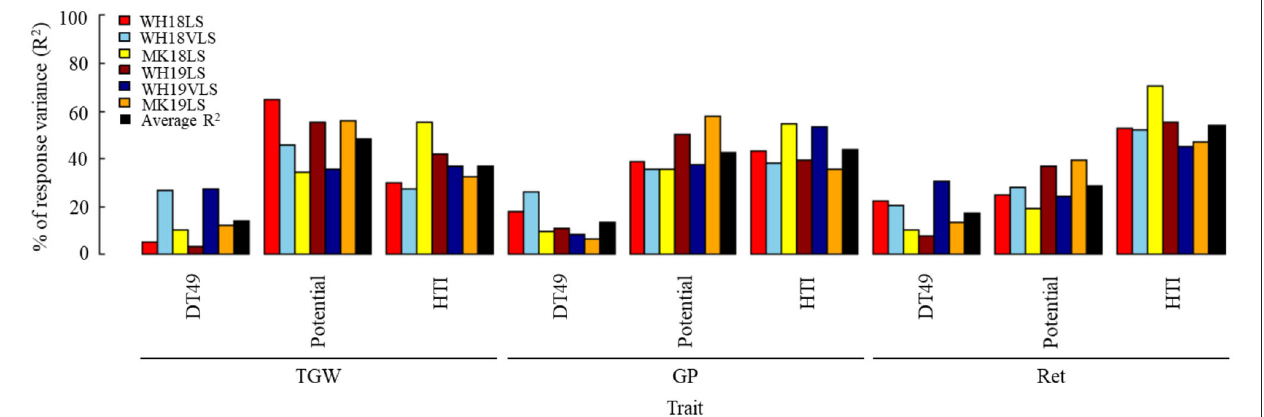
FIGURE 3 | Estimated contribution (% of the variance, R 2 ) of the trait potential, time to flowering, and heat tolerance index to thousand-grain weight (TGW), grain plumpness (GP), and retention (Ret) under delayed sown/heat-stress conditions. Environment definitions are as defined in Table 1 . of the observed variation in TGW, GP, and Ret under delayed sown,